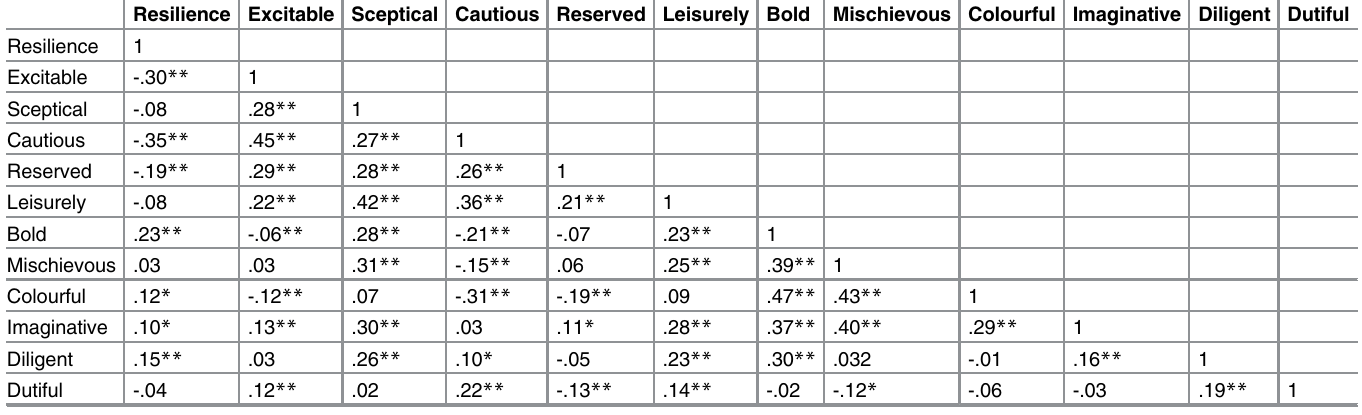
Table 7. Correlations Between Resilience (RS-14) and the 11 HDS Dark Side Traits.